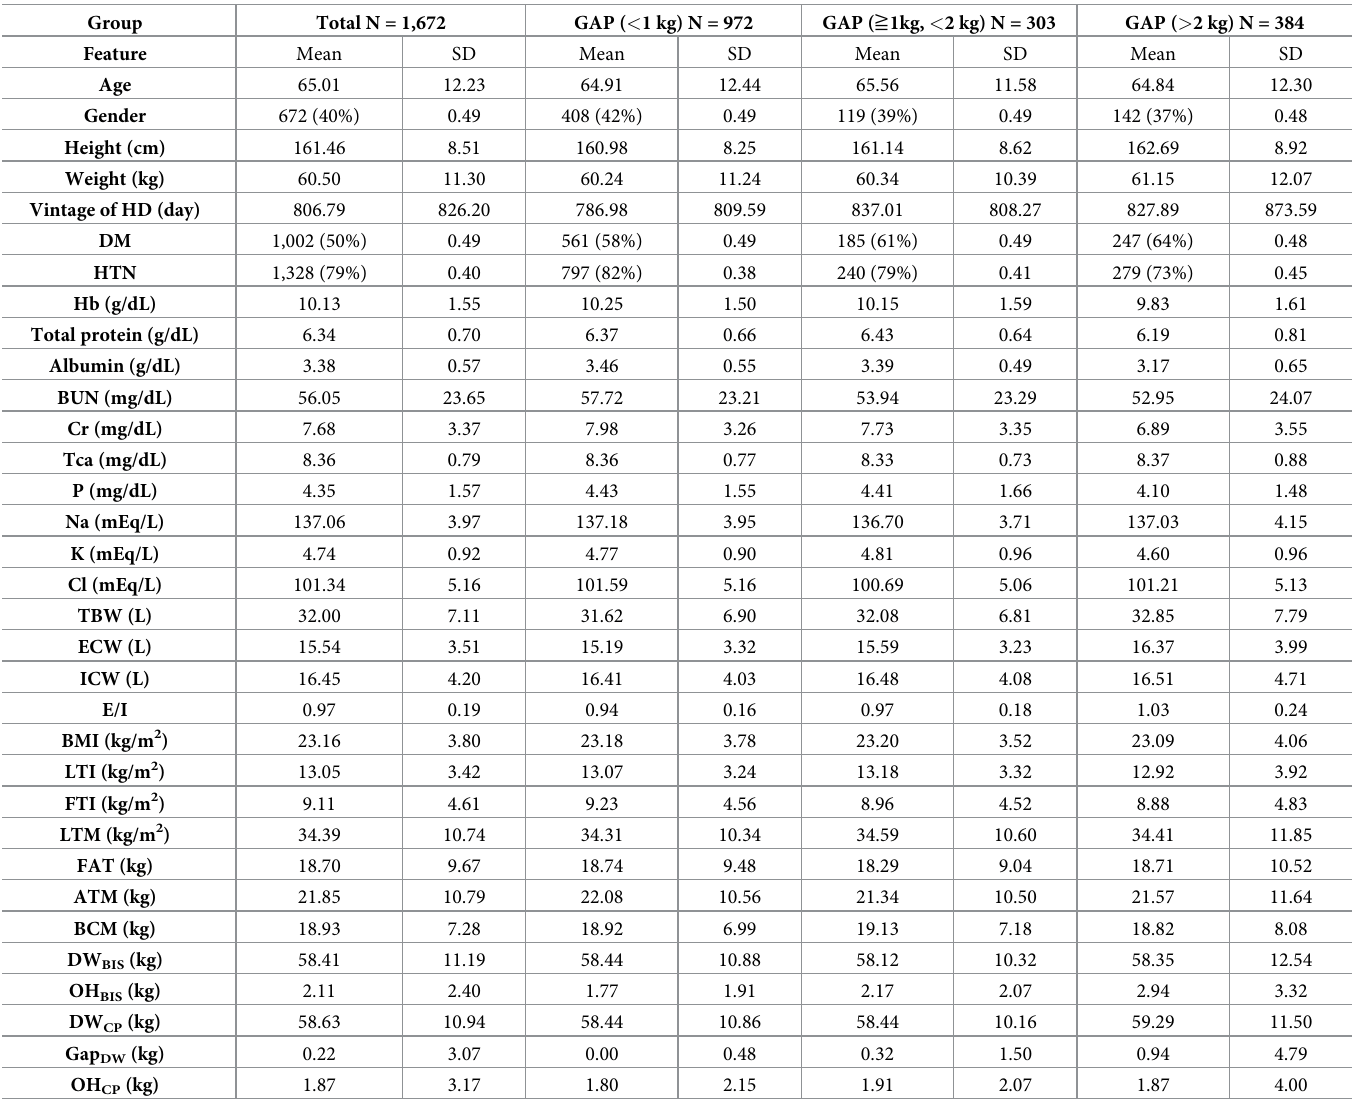
Table 1. Baseline